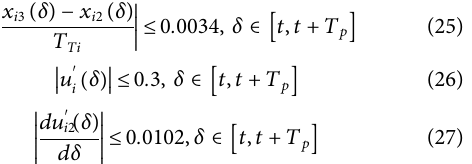
Figure 4. This control diagram is composed of a DMPC parameter correction block and a CWES coordinated control block, which are introduced as follows: 1) Dynamic modi fi cation of DMPC Each area ’ s DMPC output are modi fi ed by β , and β (0 – 1) can be dynamically achieved through FLC1 as shown in Figure 4. The input variables Frequency deviation and frequency change rate are chosen as FLC1 ’ s input, and the data range can be found in reference (Peng et al., 2019). The fuzzy membership of FLC1 is depicted in Figure 5. The states of the input and output variables of FLC1 are described by fi ve variables, and the reasoning rule of FLC1 is de fi ned as: if frequency variation value or the absolute value of frequency change rate of local area is large, then DMPC modi fi cation coef fi cient β should be large; if frequency variation value is small and frequency change rate is nearly 0, then β should be small. The fuzzy reasoning rule of FLC1 is demonstrated in